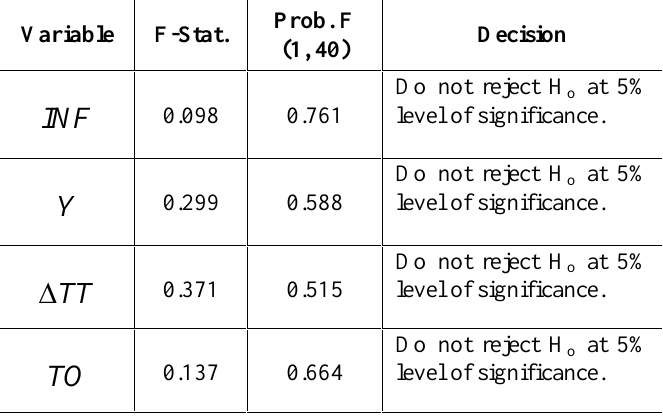
Table 3: The Chow Test for Structural Stability